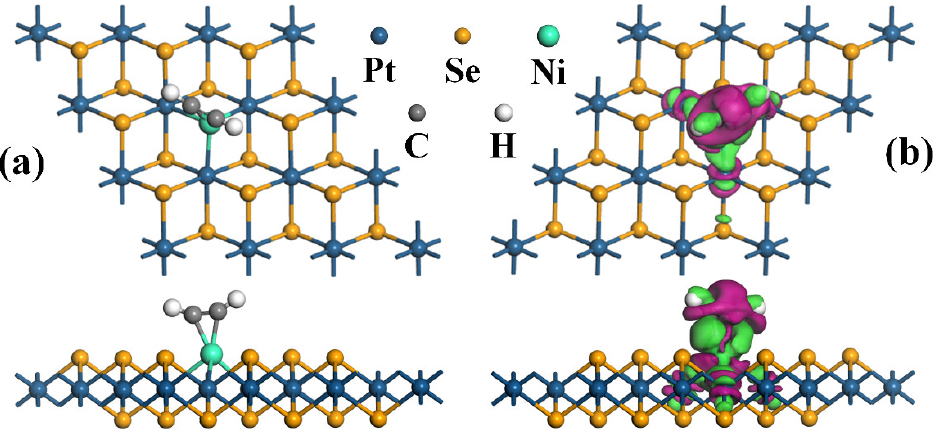
Figure 5. ( a ) The MSC, ( b ) EDD of Ni-PtSe 2 /C 2 H 2 system. In EDD, the green (rosy) areas indicate electron accumulation (depletion).